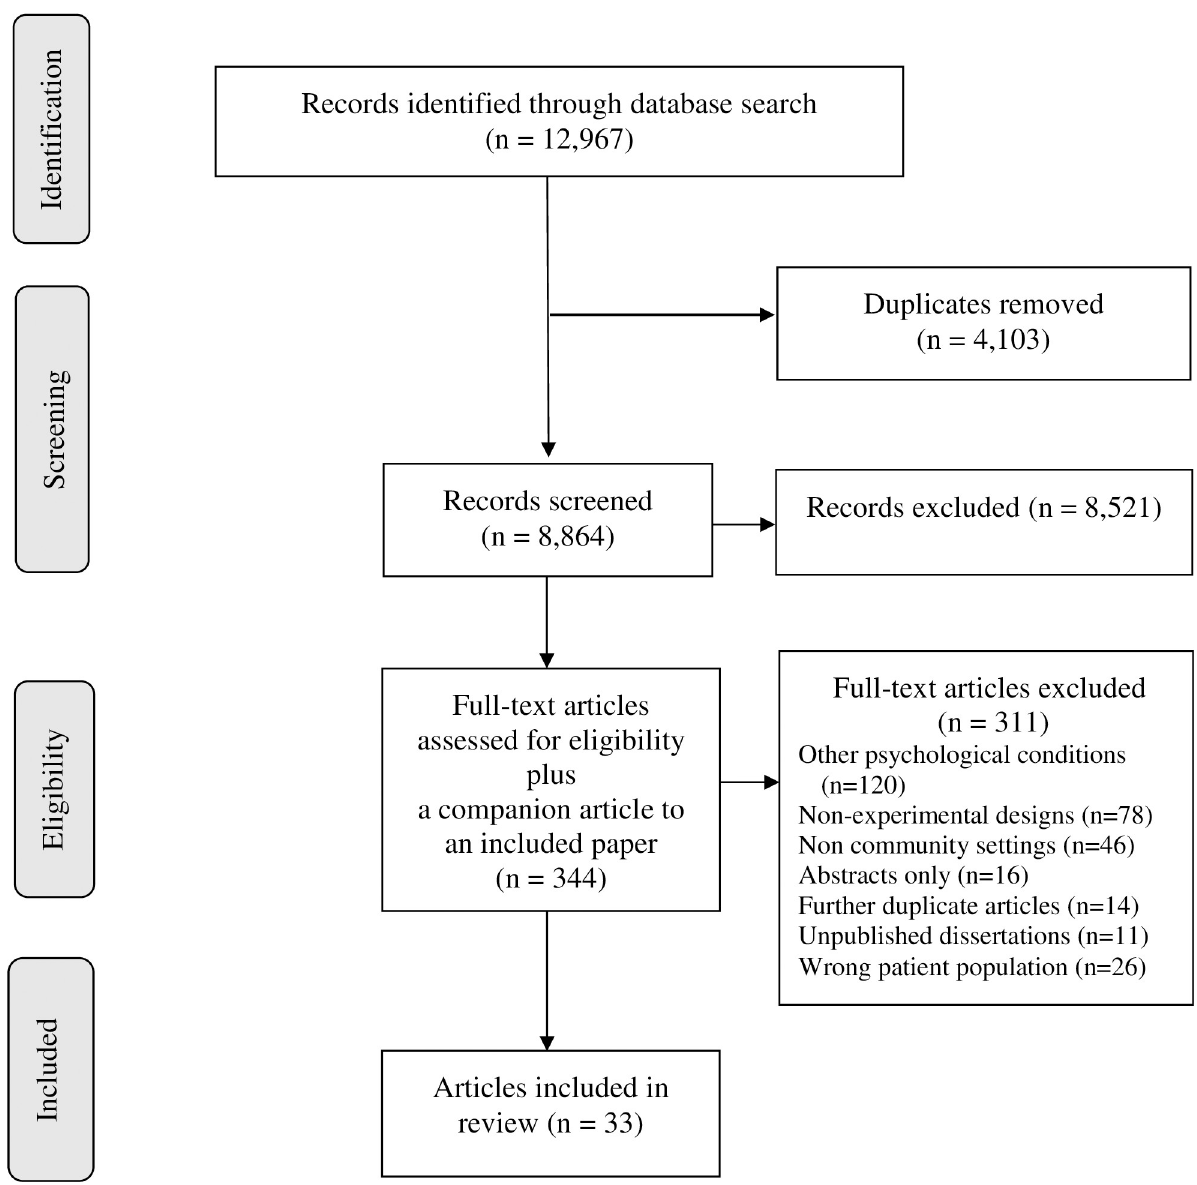
Fig 1. PRISMA diagram of a review of trauma-informed